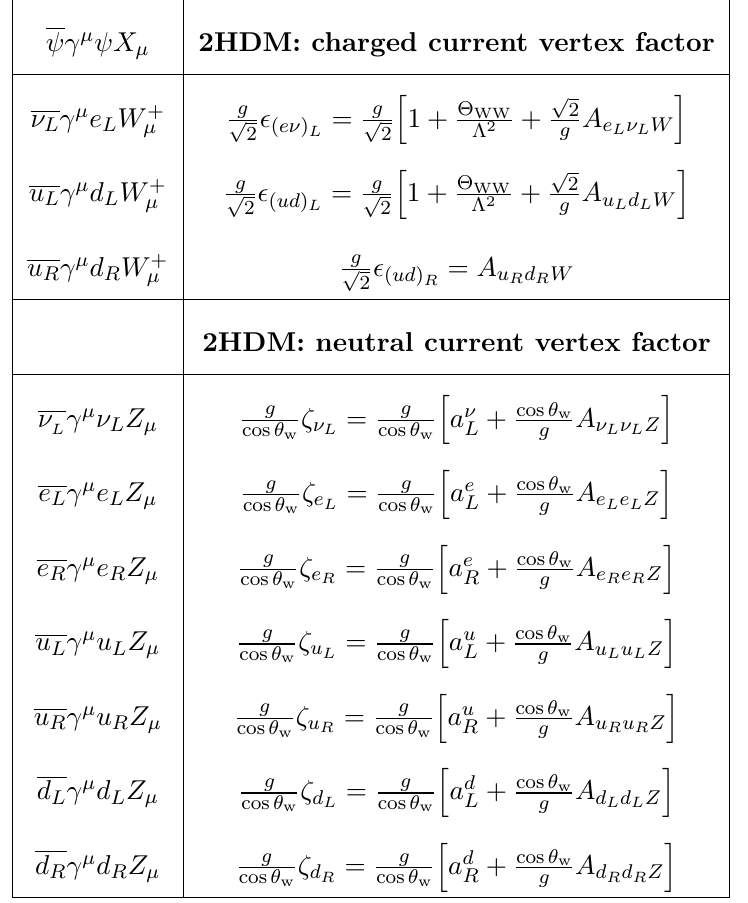
Table 27. 2HDM: coupling of gauge bosons and fermions. The detailed structures of the A ’s are given in table 28. Hermitian conjugate vertices are not separately